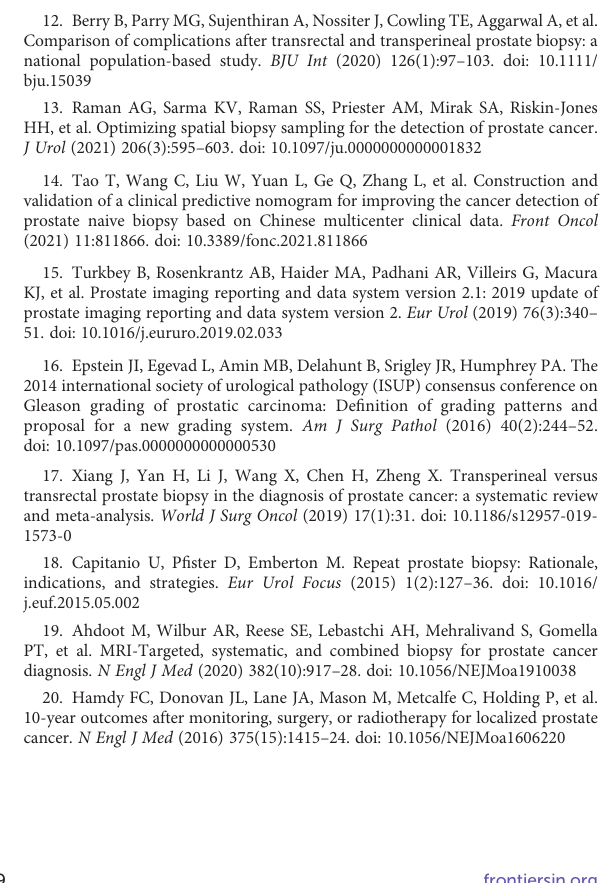
SUPPLEMENTARY FIGURE 1 TherepresentativeimagesofmpMRIofsixpatients: (A) PI-RADSscore1:Normal peripheralzone,axialT2WIshowsuniformlyhyperintensivesignalintensity,high b -value DWI and ADC also show no abnormality (white arrow); (B) PI-RADS score2:Axial T2WIshowsdiffusehypointensity withindistinctmargin,high b - value DWI exhibits slightly hyperintense and indistinct hypointense on ADC (white arrow); (C) PI-RADS score 3: Axial T2WI exhibits non-circumscribed moderatehypointensityinleftperipheralzone,DWIshowsmildlyhyperintense onhigh b -value andhypointense onADC(white arrow); (D) PI-RADSscore 4: Axial T2WI shows circumscribed, homogenous moderate hypointense focus con fi ned in right peripheral zone with greatest dimension <1.5cm, DWI sees focal obviously hyperintense on high b -valueand hypointenseonADC(white arrow); (E) PI-RADS score 5: Axial T2WI shows non-circumscribed, homogenous moderate hypointense focus con fi ned with greatest dimension markedly hyperintense and apparent hypointense on ADC (white arrow); (F) Measurement of prostate maximum diameters, green line: anteroposterior diameter,pinkline:longitudinaldiameter,brownline:transversediameter. SUPPLEMENTARY FIGURE 2 Spearman correlation analysis between clinical variables and biopsy results indicated PI-RADS score and PSAD were closely related to the detection of PCa and csPCa. *, P < 0.05; **, P <0.01; ***, P